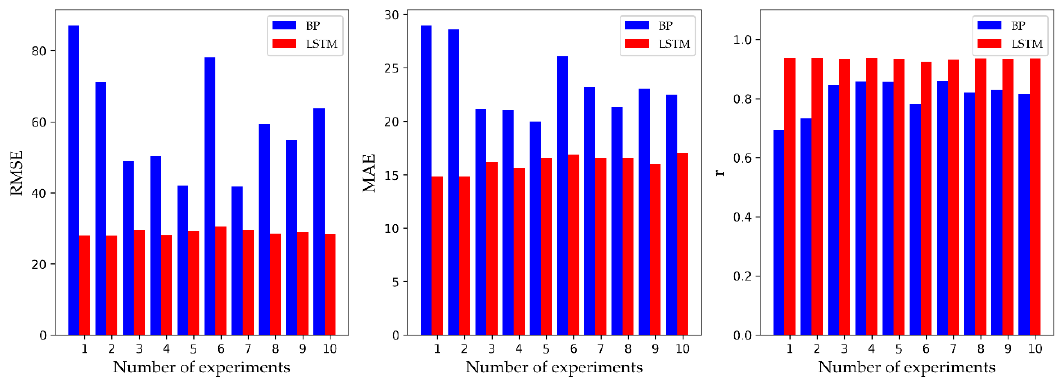
Figure 8. The statistics of 10 experimental results of the BP model and LSTM model. The left-hand side is the RMSE, the middle is the MAE, and the right-hand side is the r